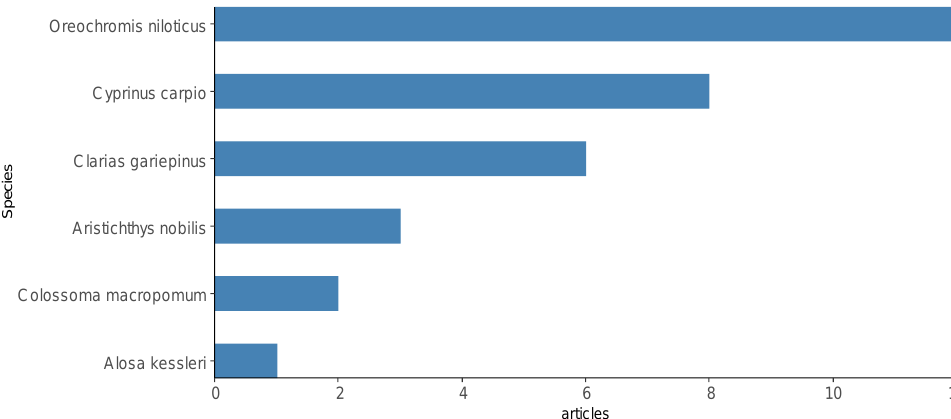
Figure 8. Some aquaculture species most sampled by the articles selected in the integrative review on the microbiological diagnoses of Salmonella spp. in aquaculture between 2000 and 2020.